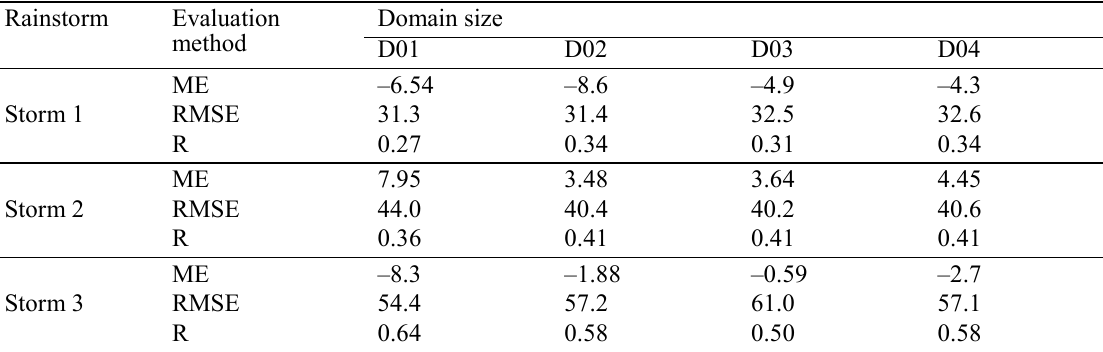
Table 4 Statistical evaluation of simulations at different domain size